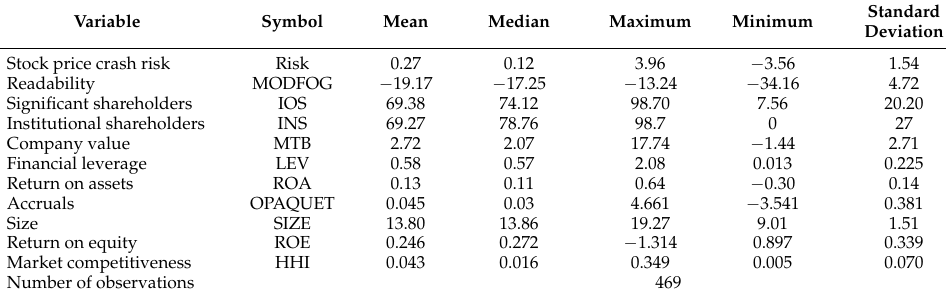
Table 2. Descriptive statistics of variables.